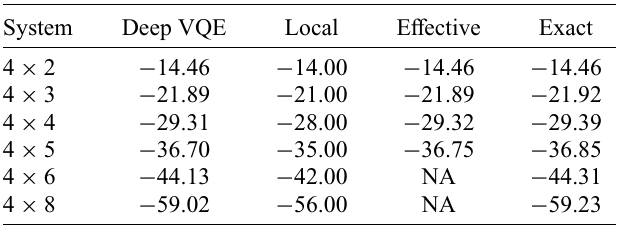
TABLE II. Numerical results for 4 × N Heisenberg antiferro- magnetic systems shown in Fig. 3(a). “Deep VQE” indicates the results obtained by the proposed scheme. “Local” indicates the energy calculated from a product state of the local ground state (cid:2) , i.e., H eff | ψ . “Effective” means the exact ground-state energy 0 00 of H eff . “Exact” is a ground-state energy calculated by Lanczos method on a simulator; the exact energy for the 4 × 8 system is computed by use of a quantum spin solver QS 3